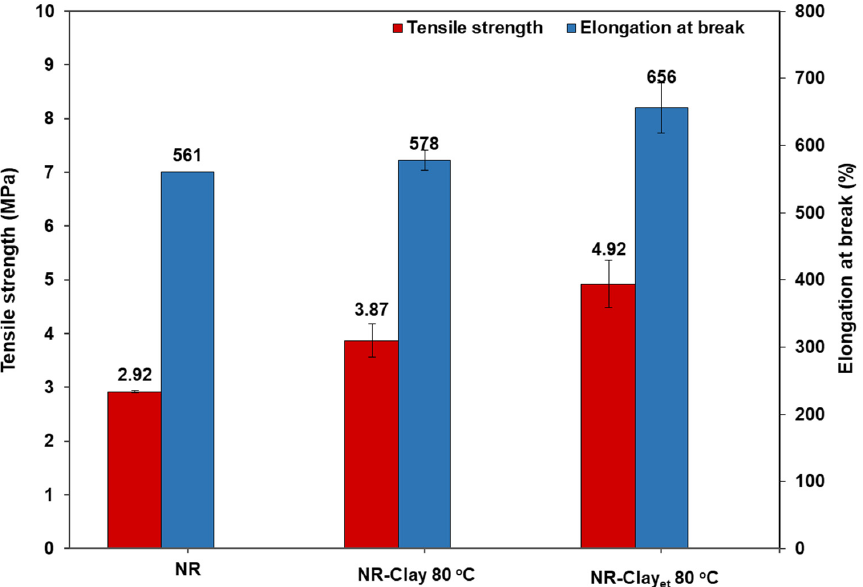
Figure 6. Tensile strength and elongation at break of vulcanized NR, NR-Clay composites at vari- ous mixing temperatures (60 ° C, 80 ° C) and NR-Clay composites of bentonite clay dispersed in